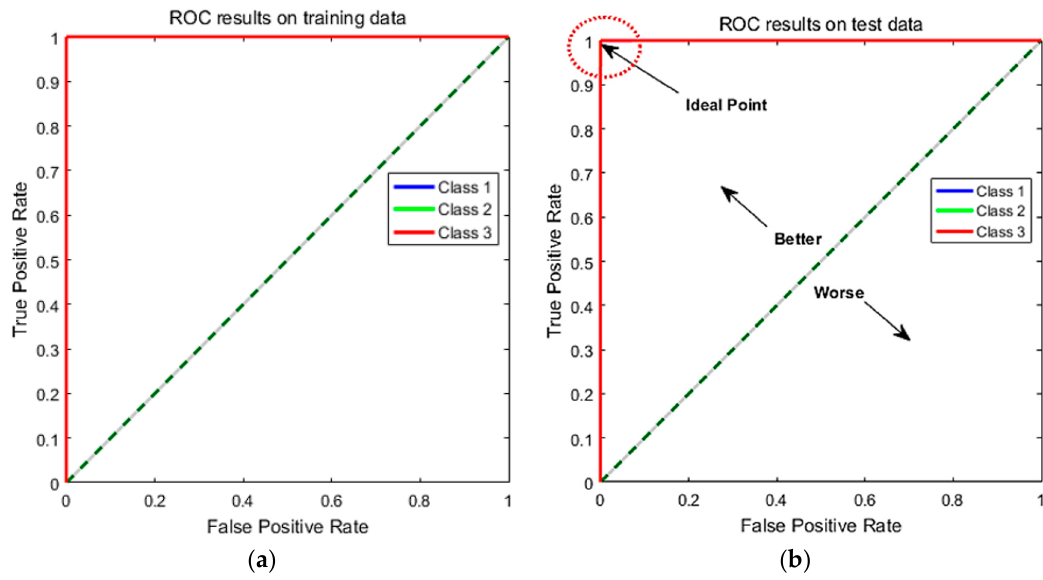
Figure 10. ROC curves for model evaluation. One ROC curve has been drawn per class.: ( a ) Performance on training dataset; ( b ) Performance on test dataset while indicating ideal and worst point in ROC space.